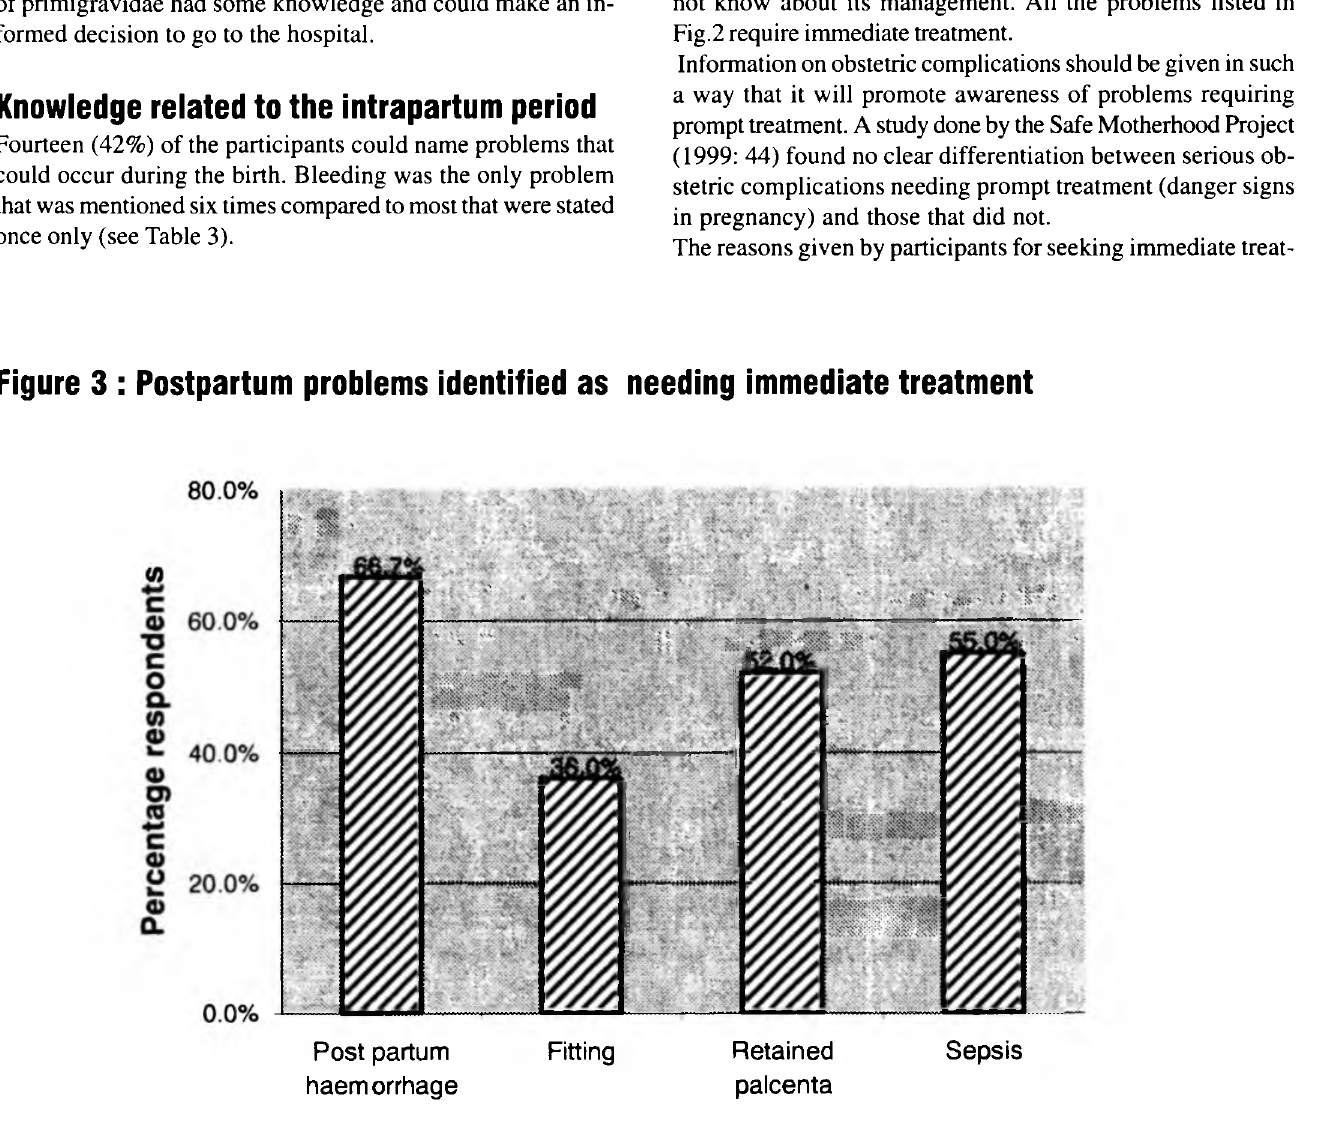
Figure 3 : Postpartum problems identified as needing immediate